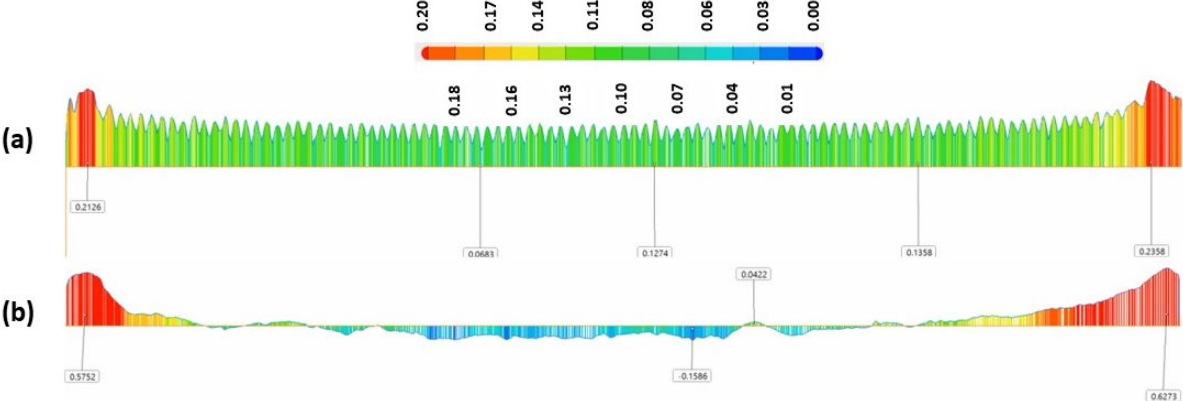
Figure 10. In ‐ plane section view of S1; ( a ) before and ( b ) after laser polishing. Figure 10. In-plane section view of S1; ( a ) before and ( b ) after laser